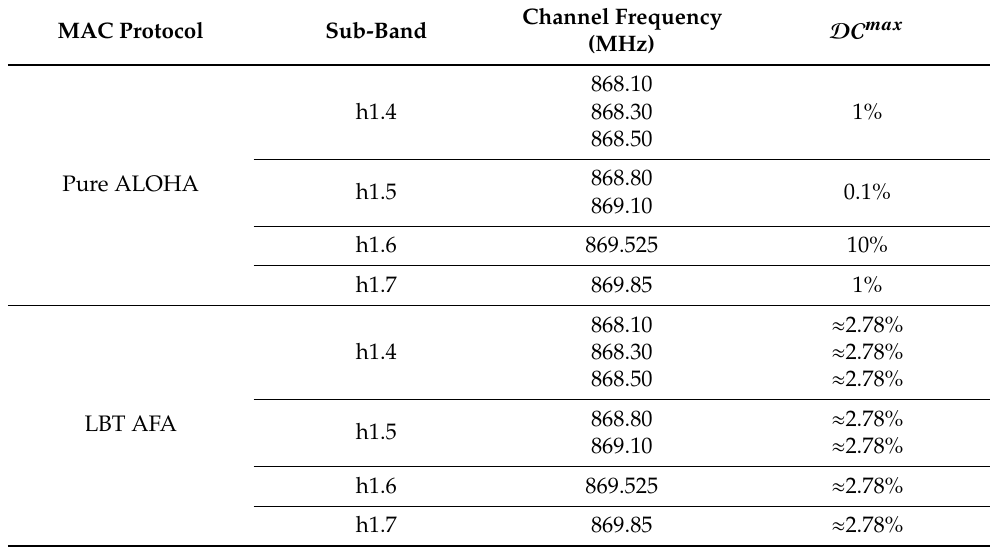
Table 3. SHC scenario—channel configuration.